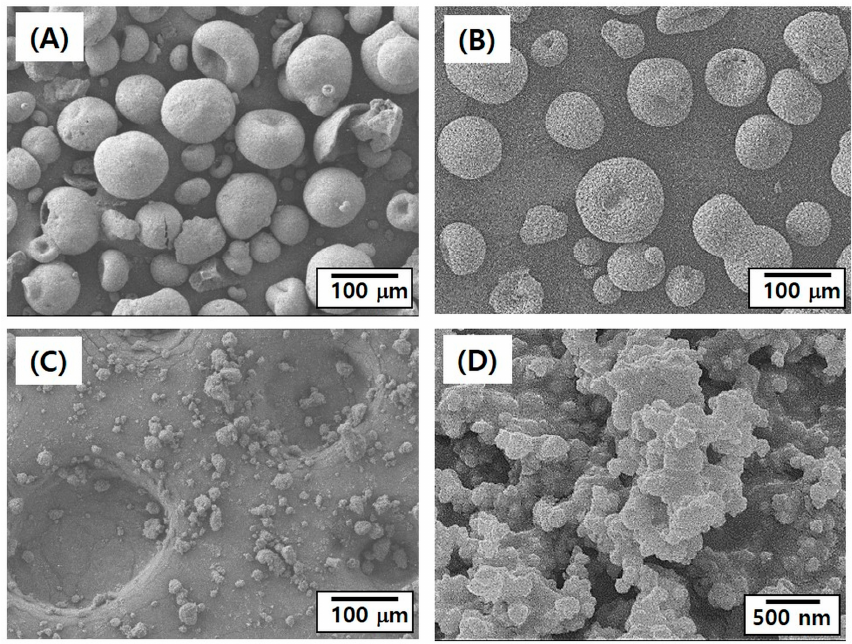
Figure 2. Representative FE-SEM images of ( A ) as-received 4Y-PSZ granules, ( B ) calcined granules, and ball-milled powders at low ( C ) and high ( D ) magnifications.